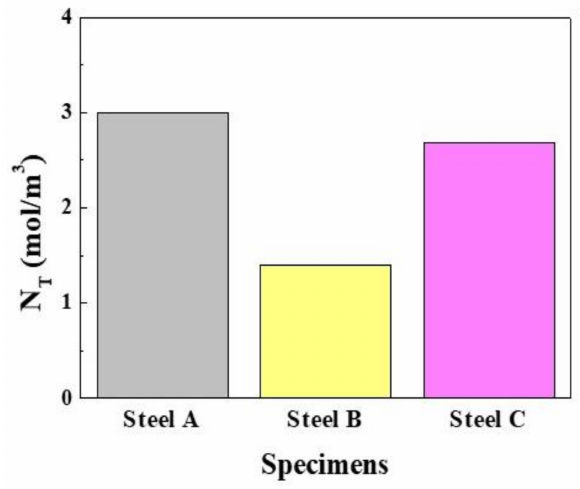
Figure 9. Total hydrogen trap density in the